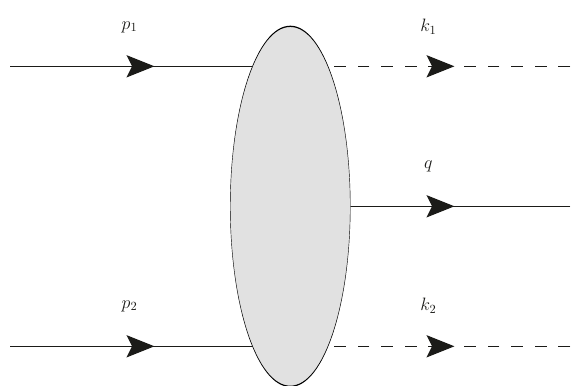
Figure 6 . Kinematics for double real corrections of the Drell-Yan process. p 1 and p 2 are incoming momenta, q is outgoing. The PSI is performed over the dashed momenta k 1 and k 2 .